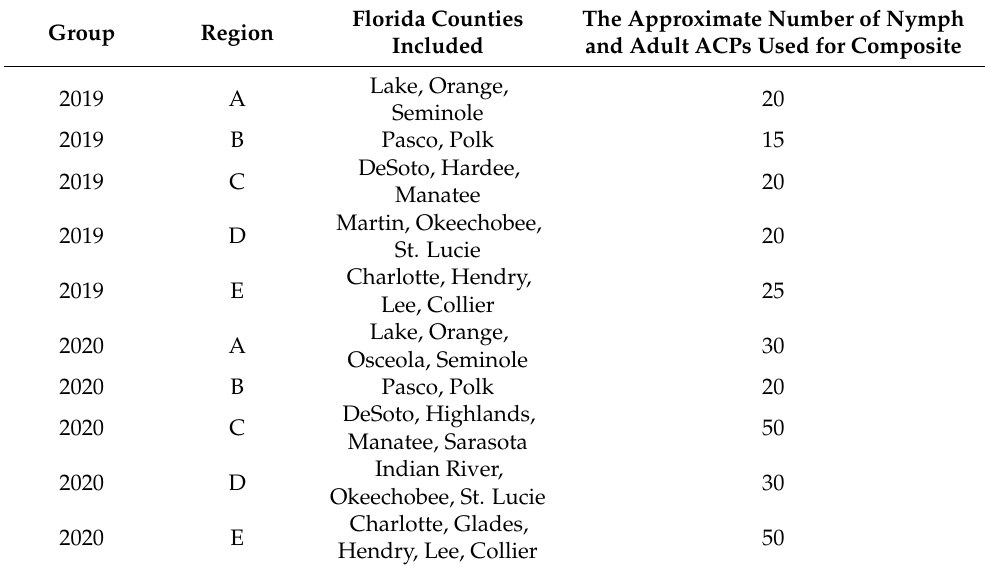
Table 1. Composition of Florida regional Asian citrus psyllid ( Diaphorina citri ; ACP) samples per yearly group (five regions) compiled for total RNA